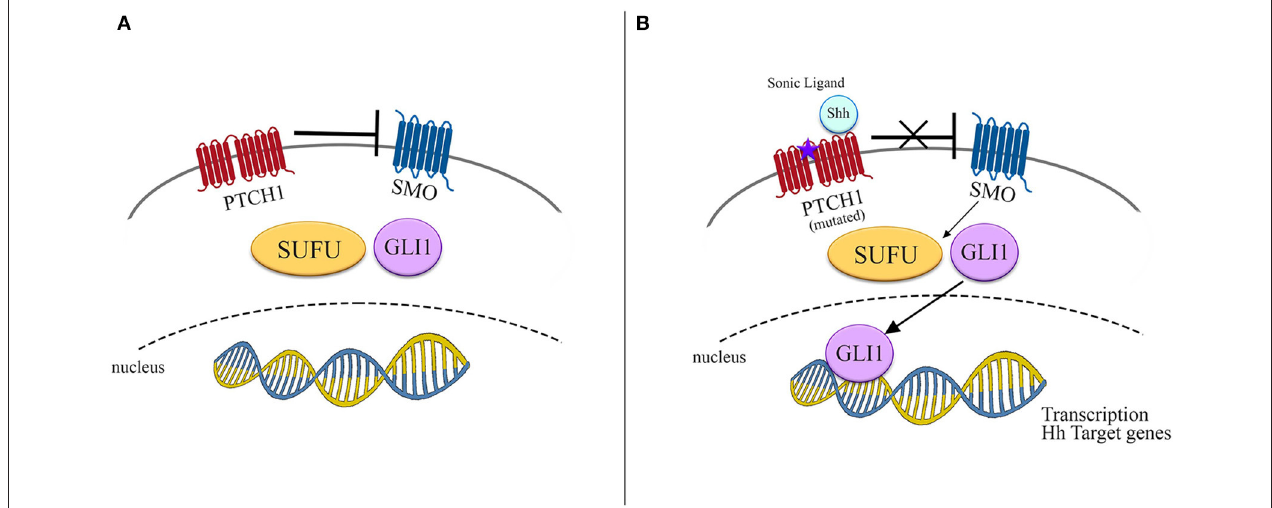
FIGURE 1 | Schematic representation of Hedgehog signaling pathway. (A) In normal conditions SMO is inhibited by PTCH1 and no signals reach the nucleus to promote transcription. (B) In presence of either its ligand as Shh or mutated PTCH1 , SMO is derepressed, promoting the transcription of Hh target genes by activation of